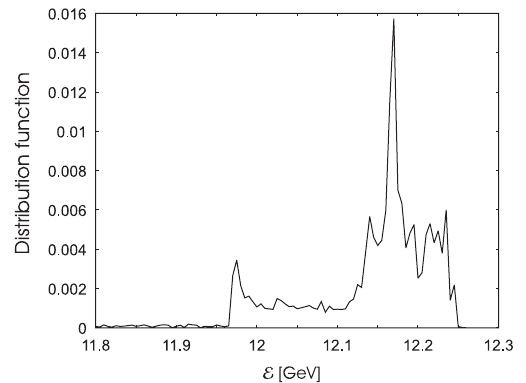
FIG. 8. The final energy distribution function for continuous reflection and acceleration at the variable undulator step. The parameters are chosen as in Fig. 6.